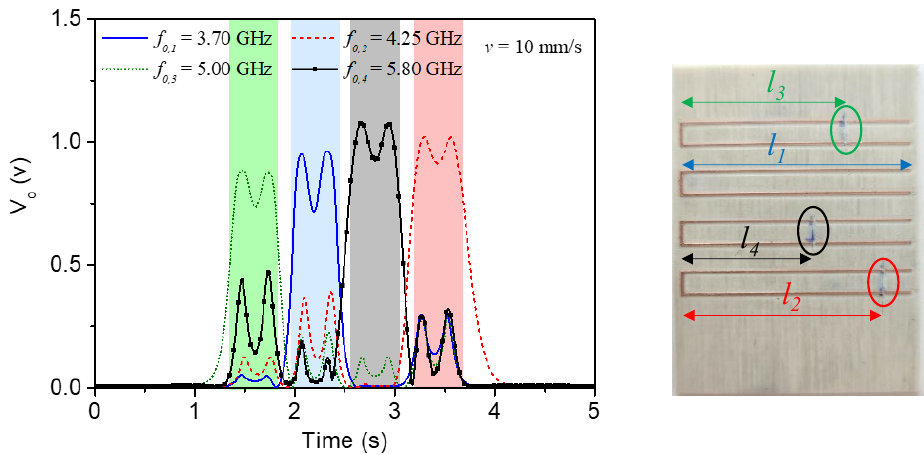
Figure 14. Envelope functions for the four frequencies corresponding to the (second) resonances of the four C-shaped resonators, for the indicated encoder, with cuts in certain resonators. The lengths of the resonators, after practicing the cuts, correspond to those lengths shown in Figure 7b.